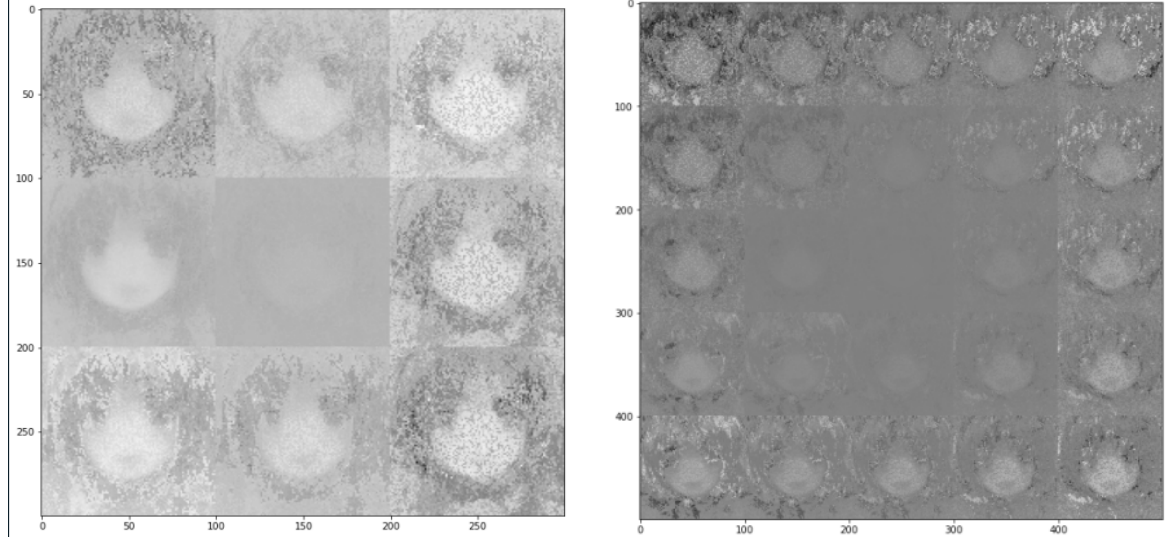
Figure 11. Two sample output images obtained from the VAE model based on the anime-girl dataset (Section